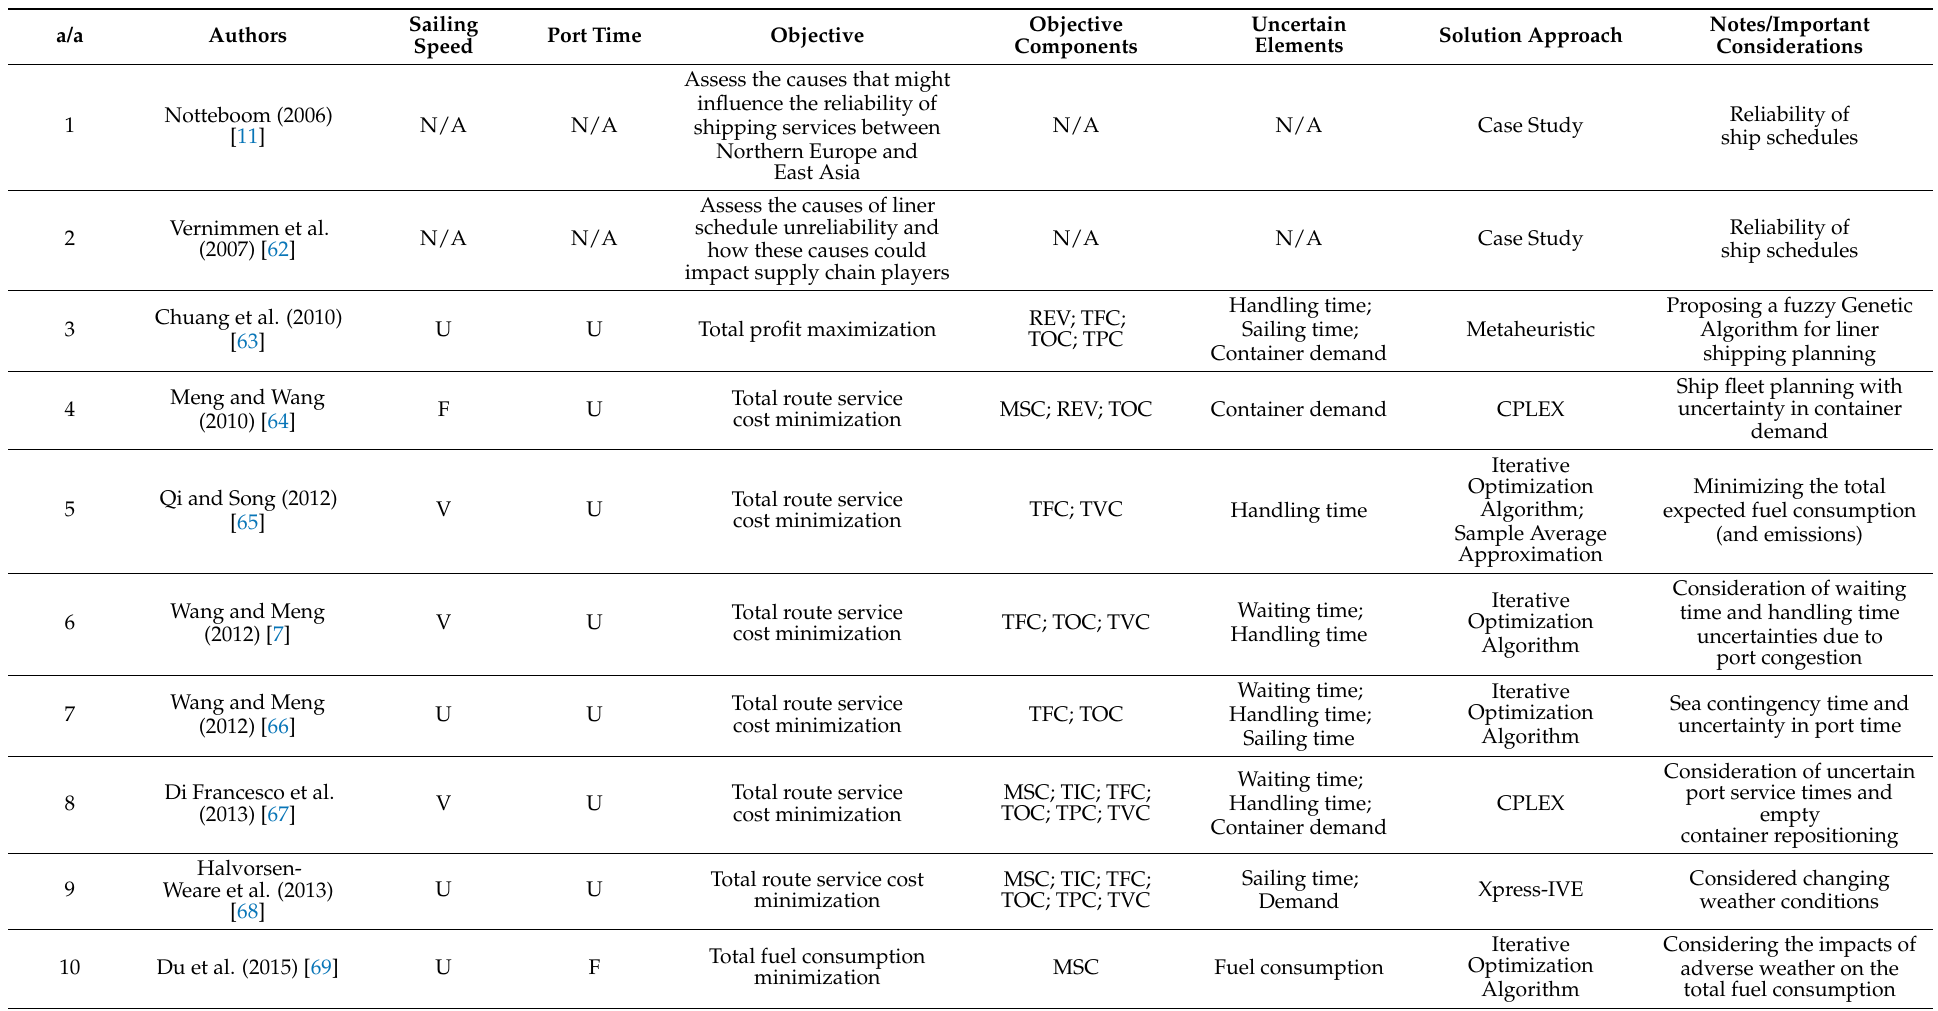
Table 1. Summary of the reviewed studies on uncertainties in liner shipping